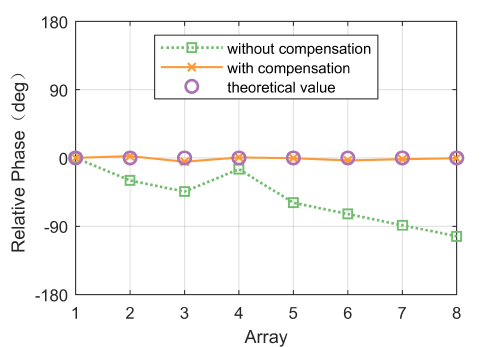
Figure 8. Phase characteristic curve of